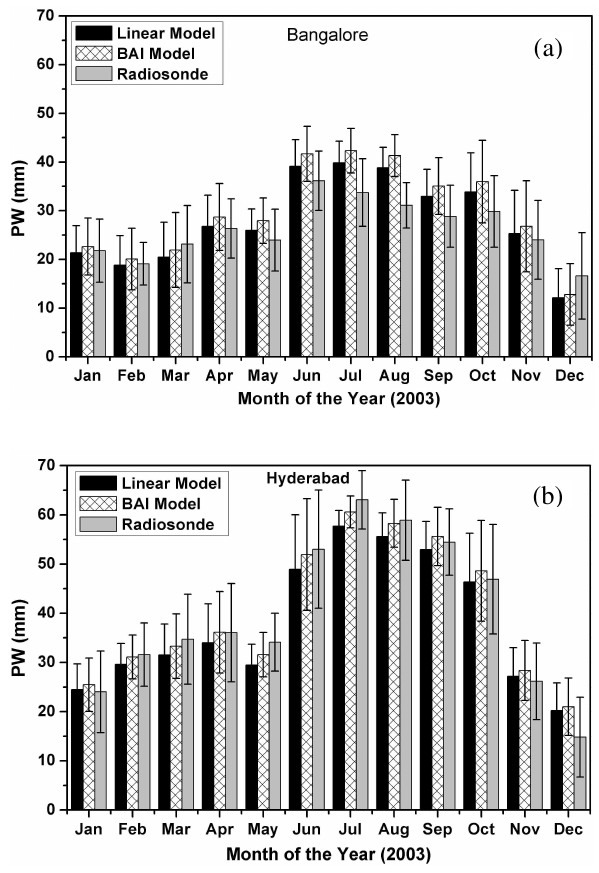
Fig. 13. The figure shows the performance of the site-specific linear and BAI regional models over two locations in Indian sub- continent. The bar-chart showing a comparison of monthly mean values of PW GPS using the temperature independent site-specific linear model (Eq. 6b) and BAI regional model (Eqs. 7, 8) for the year 2003 along with corresponding values of PW derived from ra- diosonde data at Bangalore (a) ; and same for Hyderabad (b)